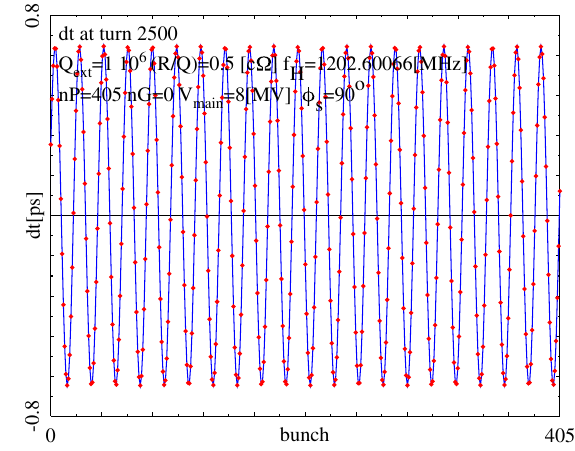
FIG. 5. (Color) Program check: As Fig. 4 but for f H about (cid:3) f (cid:6) 21 (cid:1) f Rev away from a machine line; the emerging pattern has 21 crests and troughs.